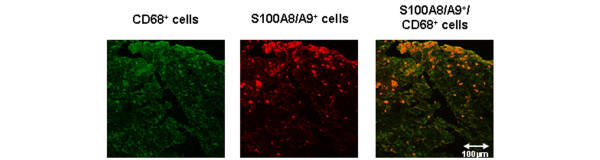
Expression of CD68 and the S100A8/A9 heterodimer in the synovial tissue (ST) of rheumatoid arthritis (RA). Cryostat sections of ST samples from patients with RA were incubated with mouse immunoglobulin (Ig) G1 monoclonal antibody (mAb) against the S100A8/A9 complex or control mAb, followed by incubation with rhodamine-conjugated donkey anti-mouse IgG1 mAb, and were then incubated with fluorescein isothiocyanate-conjugated anti-CD68 mAb. Two-color immunofluorescence confocal images were obtained for CD68 and S100A8/A9 expression (green and red staining, respectively). The two images were superimposed; double-positive cells are shown in yellow. No isotype-matched control mAb was observed. Similar staining patterns were obtained in additional analyses with two synovial tissue samples from different patients.